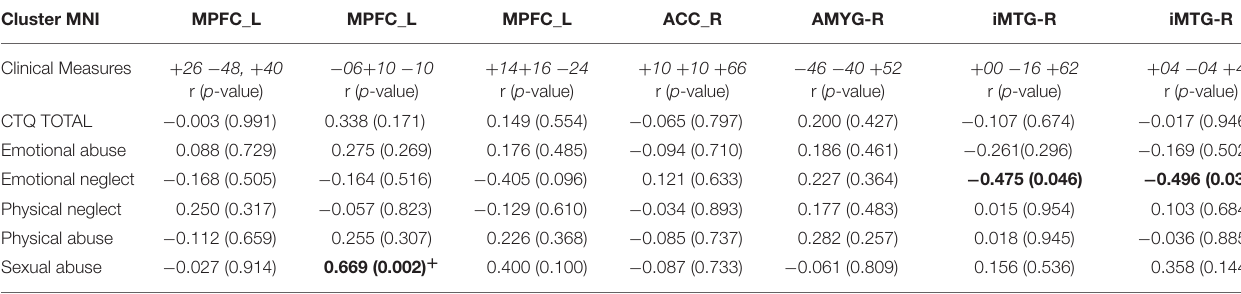
TABLE 4 | Correlations between functional connectivity and clinical measures in BPD patients. Cluster MNI MPFC_L MPFC_L MPFC_L ACC_R